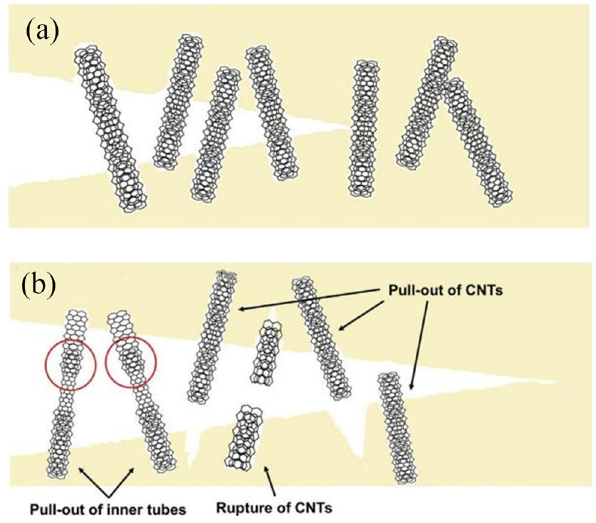
Figure 13: Fracture toughening mechanisms: ( a ) crack bridging of CNTs and ( b ) pull - out and rupture of CNTs [ 78 ] .